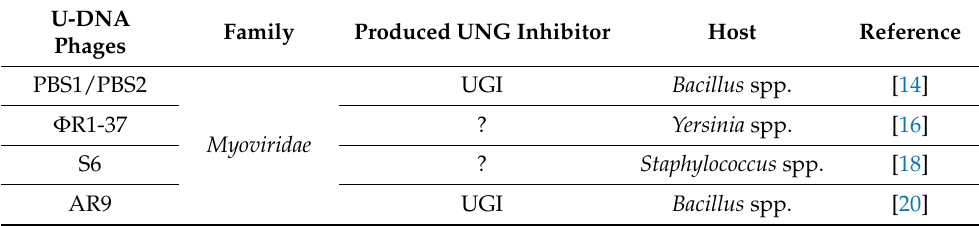
Table 1. Uracil-DNA